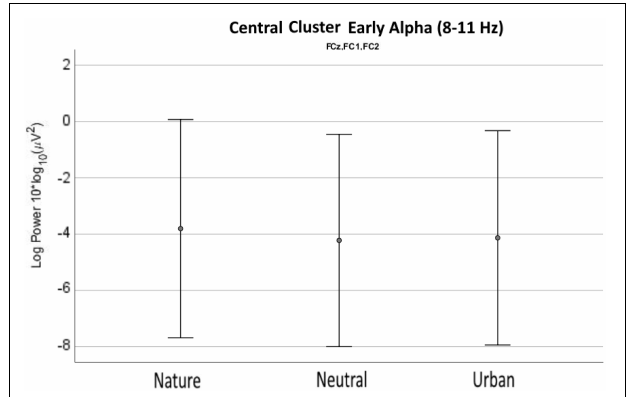
FIGURE 6 | Early alpha waves power density values as recorded (averaged) over the central cluster for neutral, nature, and urban experimental conditions. Error bars show standard deviations